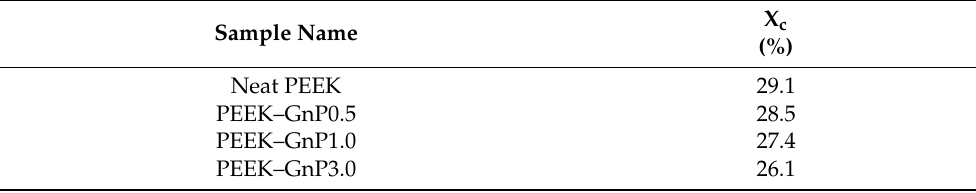
Table 2. Degree of crystallization (X c ) of the NEAT PEEK and PEEK–GnP